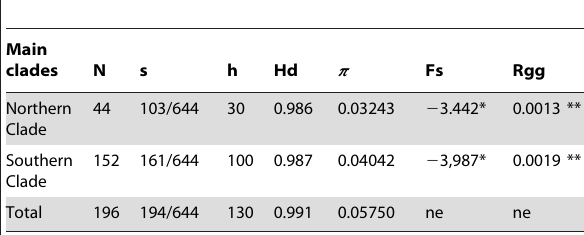
Table 1. Estimates of haplotype diversity (Hd), nucleotide diversity ( p ), Fu’s Fu test with associated levels of significance (*: , 0.05, **: . 0.05), and raggedness index (Rgg) for the two main phylogroups described by the Bayesian